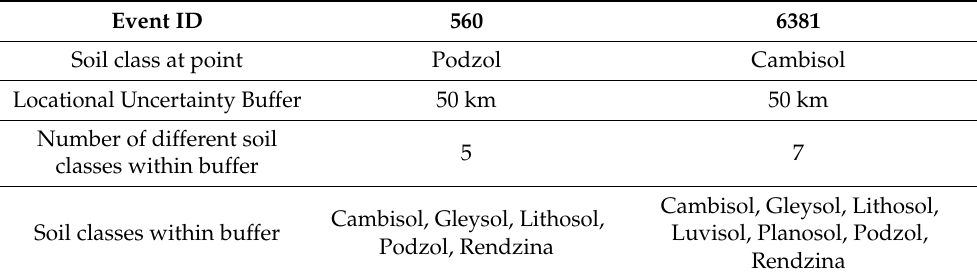
Figure 4. Events 560 and 6381 buffered by location uncertainty, with soil overlay within each buffer. Background of soil types, outside buffers, was filter out for better display. Base map is from ArcGIS ® , the intellectual property of Esri, used herein under license. Copyright© Esri. Table 6. Impact of location uncertainty (buffered area) values vs. point values in soil class determina- tion, sample events 560 and